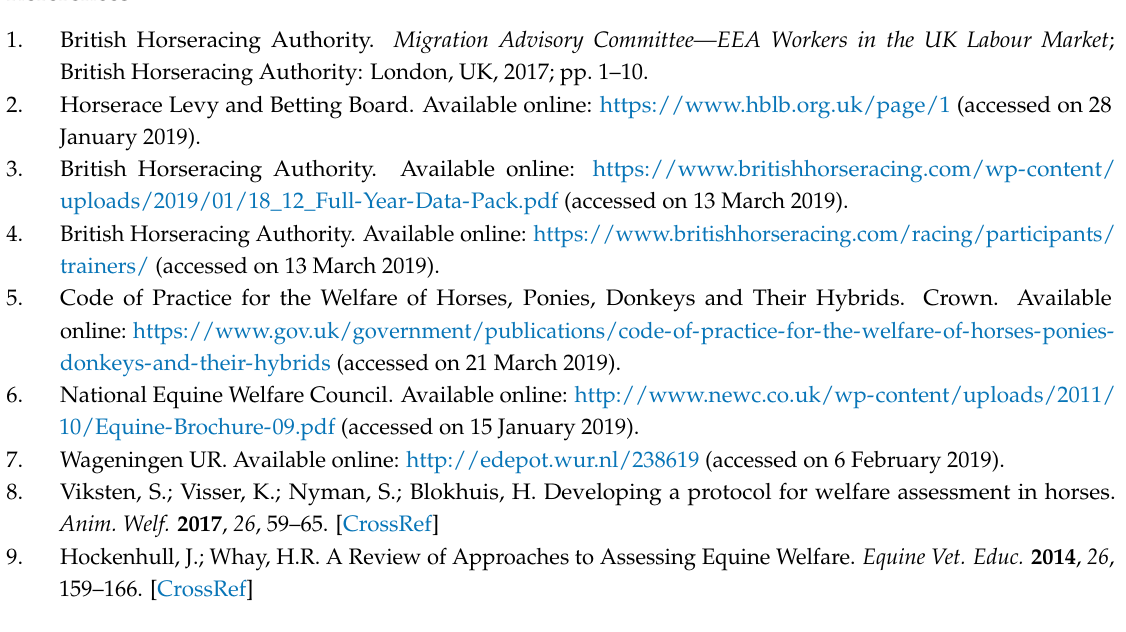
Table S1: Stakeholders perceptions of minimum welfare standards and the best ‘life’ a horse in training can live for health Table S2: Stakeholders perceptions regarding minimum and best ‘life’ with regard to training, exercise and recovery. Table S3: Perceptions of participants’ opinions regarding minimum and best ‘life’ with regard to physical comfort/living environment. Table S4: Stakeholder perceptions regarding minimum and best ‘life’ with regard to feeding. Table S5: Stakeholder perceptions of minimum and best ‘life’ with regard to daily routine and monitoring. Table S6: Perceptions of participants’ opinions regarding minimum and best ‘life’ with regard to policy and procedures Table S7: Stakeholder’s perceptions of minimal welfare standards and ‘best life’ with regard to turnout/social contact. Table S8: Perceptions of participants’ opinions regarding minimum and best ‘life’ with regard to staff management and education, statements assigned to each theme and sub theme. Table S9: Perceived challenges to racehorse welfare Author Contributions: Conceptualization, H.R.W.; Formal analysis, M.V. and R.A.; Writing—original draft, D.B.; Writing—review and editing,